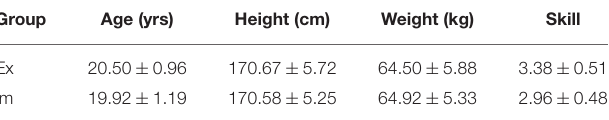
TABLE 1 | Profiles of the